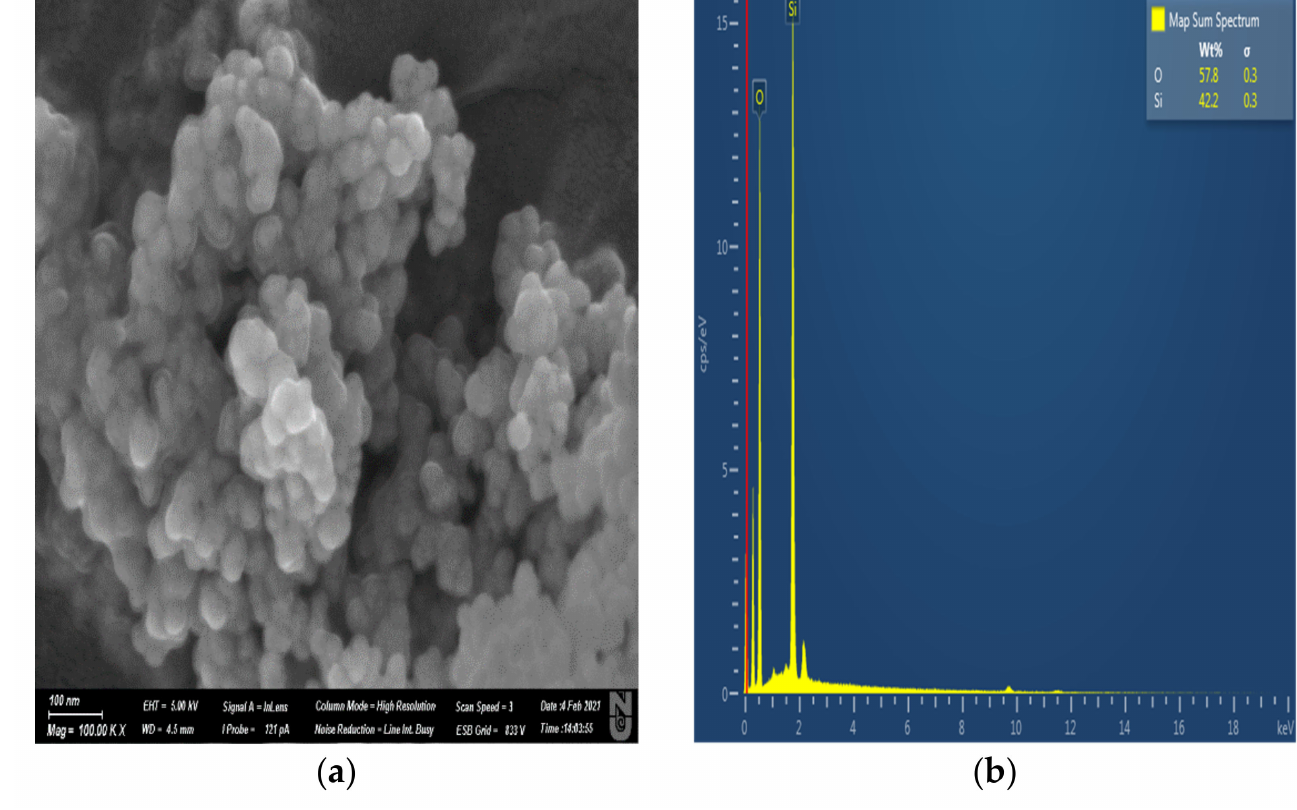
Figure 5. ( a ) Image of SiO 2 NP taken by SEM; ( b ) elemental composition of SiO 2